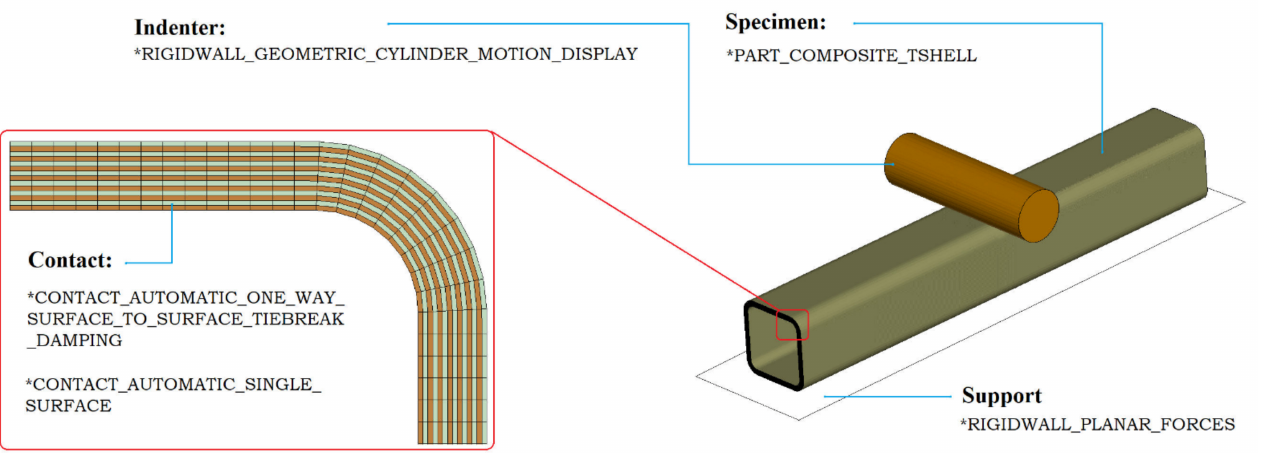
Figure 7. Developed LS-DYNA numerical model (the quarter-model reflected to enhance